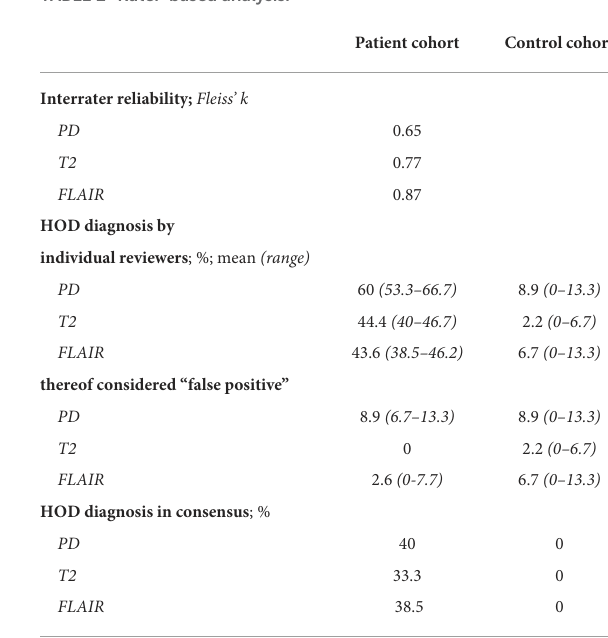
TABLE 1 Patient characteristics. TABLE 2 Rater-based